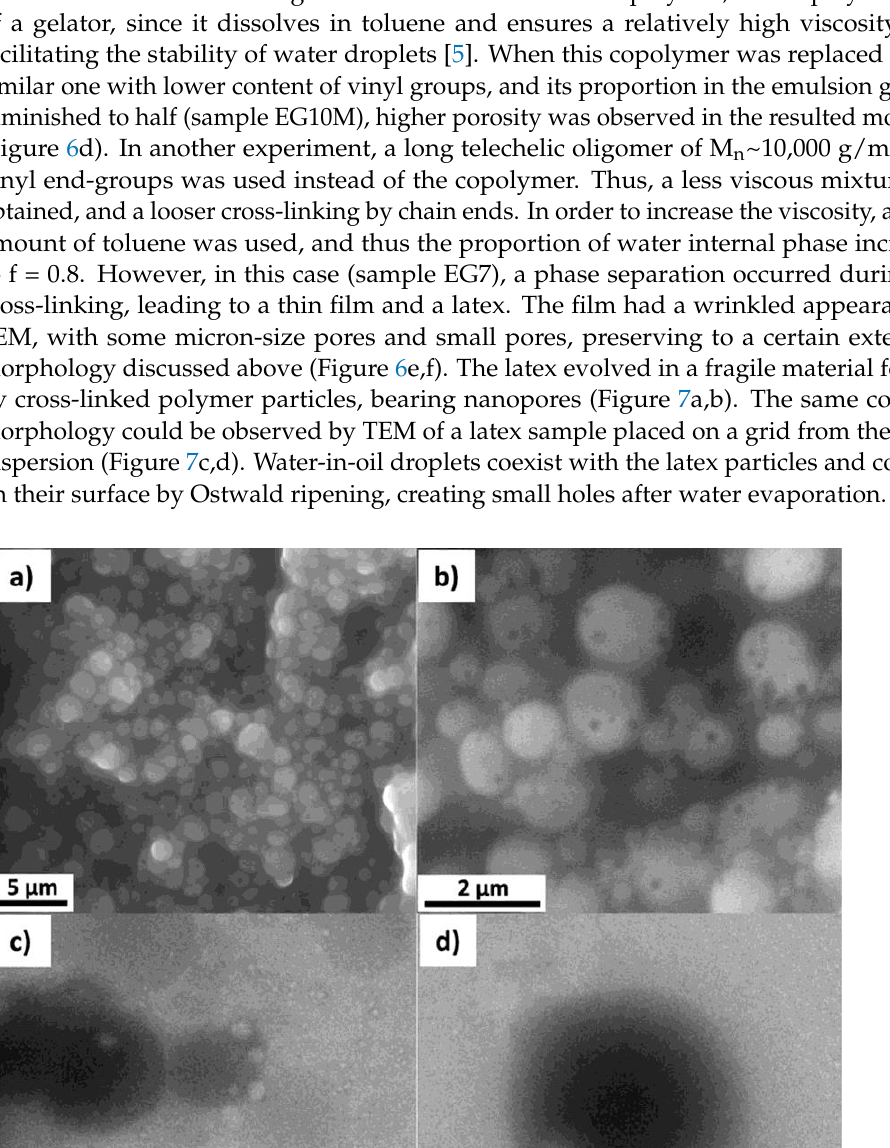
Figure 8. Polysiloxane – polyethyleneglycol porous composite obtained from an emulsion gel (sam- ple EG4).